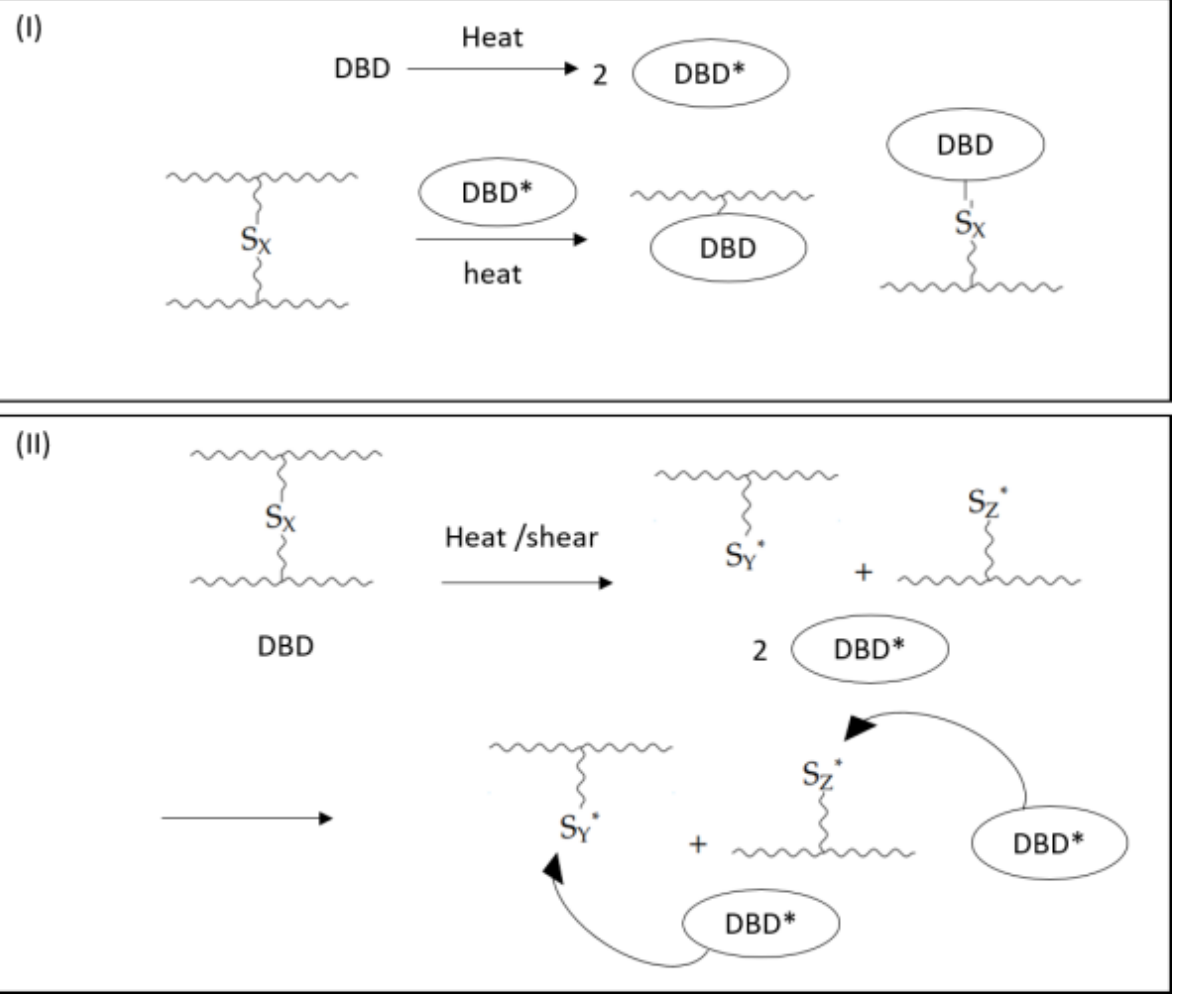
Figure 8. A proposed mechanism of DBD in the presence of heat ( I ) and heat/shear ( II ), which is supported by the literature [3,21,51,54,55].